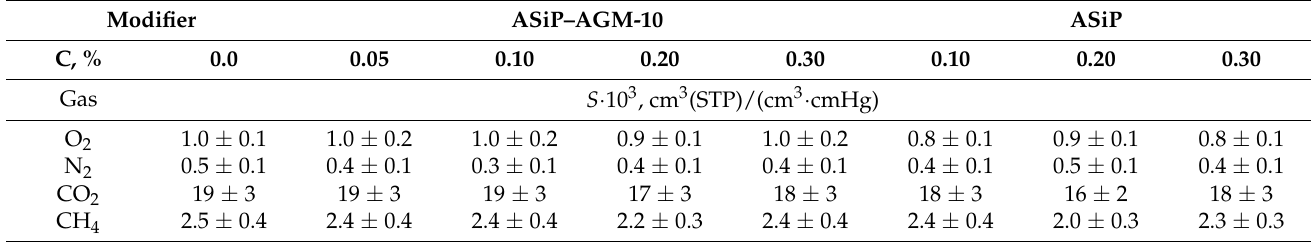
Table 4. Solubility coefficients ( S